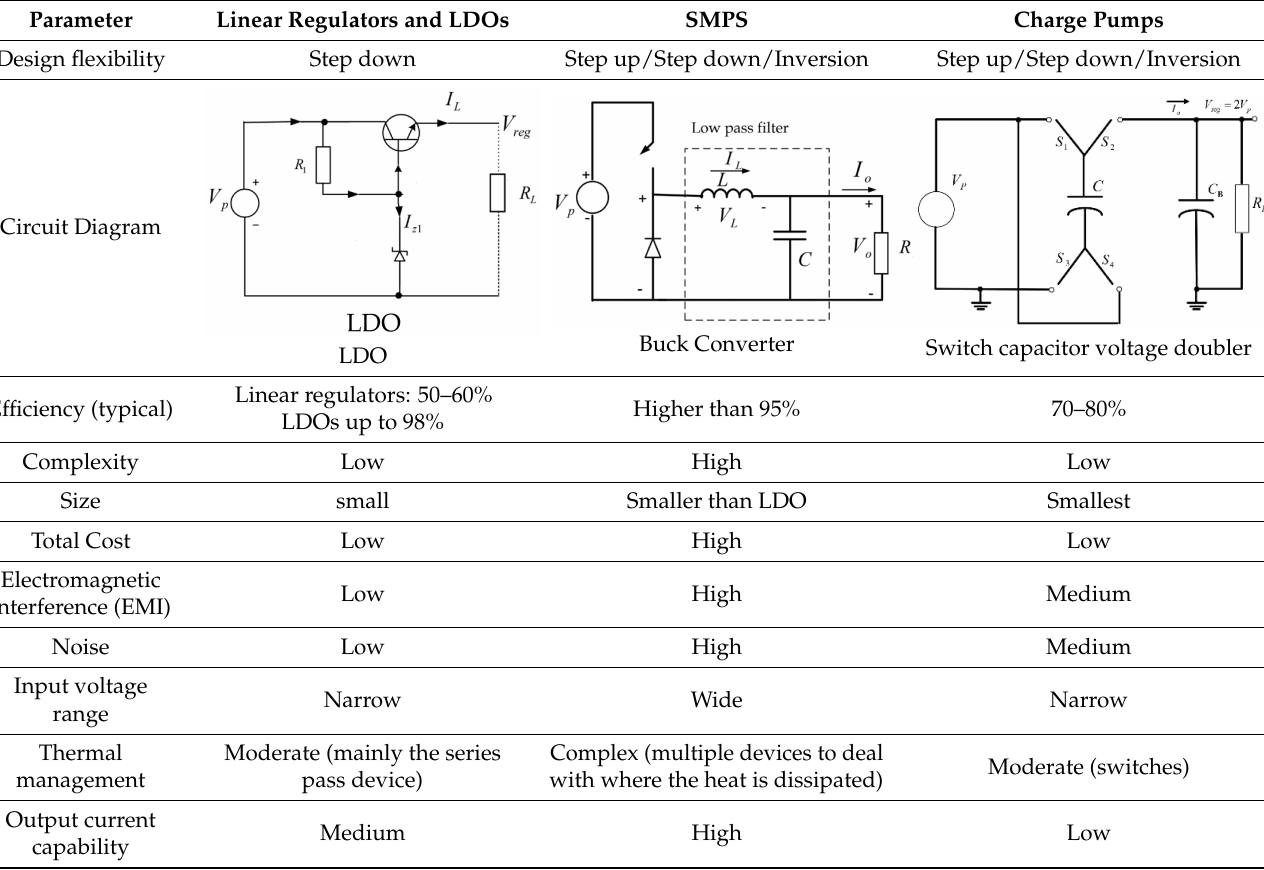
Table 1. Comparison of performance of SMPS, charge pumps, and linear